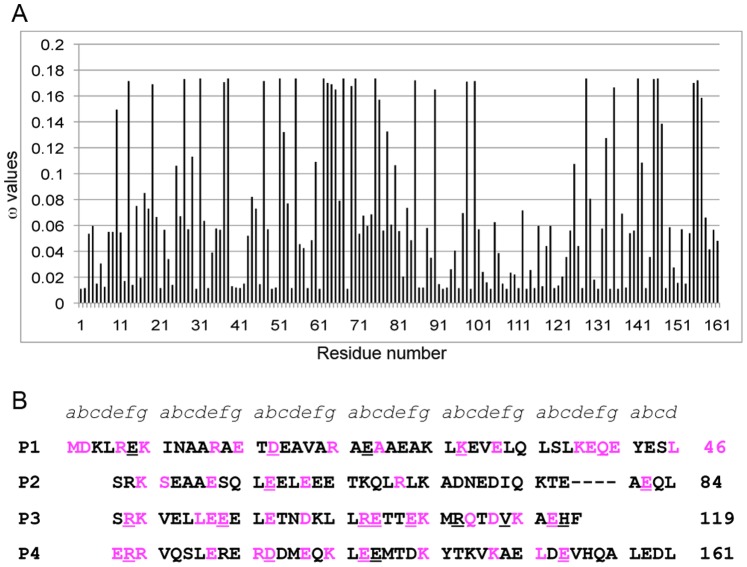
Evolutionary analysis of S. pombe tropomyosin (Cdc8p).A. Average ω values of the 161 codons of the Cdc8p sequence, where ω = dN/dS, and dN, dS are the nonsynonymous (encodes a different amino acid) and synonymous (encodes the same amino acid) substitution rates for codons, respectively. ω<1 represents negative selection, ω = 1, neutral selection, and ω>1, positive selection. The ω values for all codons of Cdc8p were<1 indicating negative selection and a highly conserved protein. The codons with average ω≤0.02 (an arbitrary value) were selected as conserved sites. B. The Cdc8p sequence showing the conserved residues (average ω≤0.02) in magenta. a–g are the positions in the heptad repeat and - - - - is the interruption in the heptad repeat (stammer) found in fungal tropomyosins. The sequence is displayed in the length of periods (P1–P4) proposed for vertebrate tropomyosins (Phillips, 1986). The positions of the 21 mutated sites are underlined.